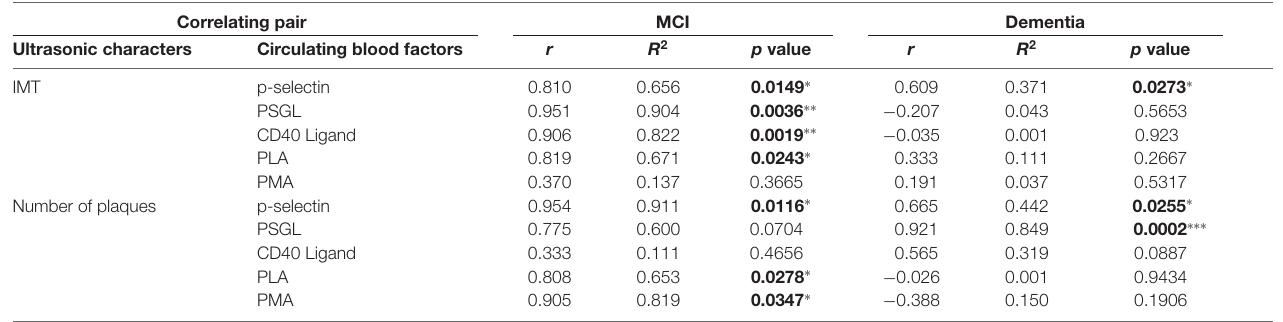
TABLE 2 | Correlation between ultrasonic characters and circulating blood factors. Correlating